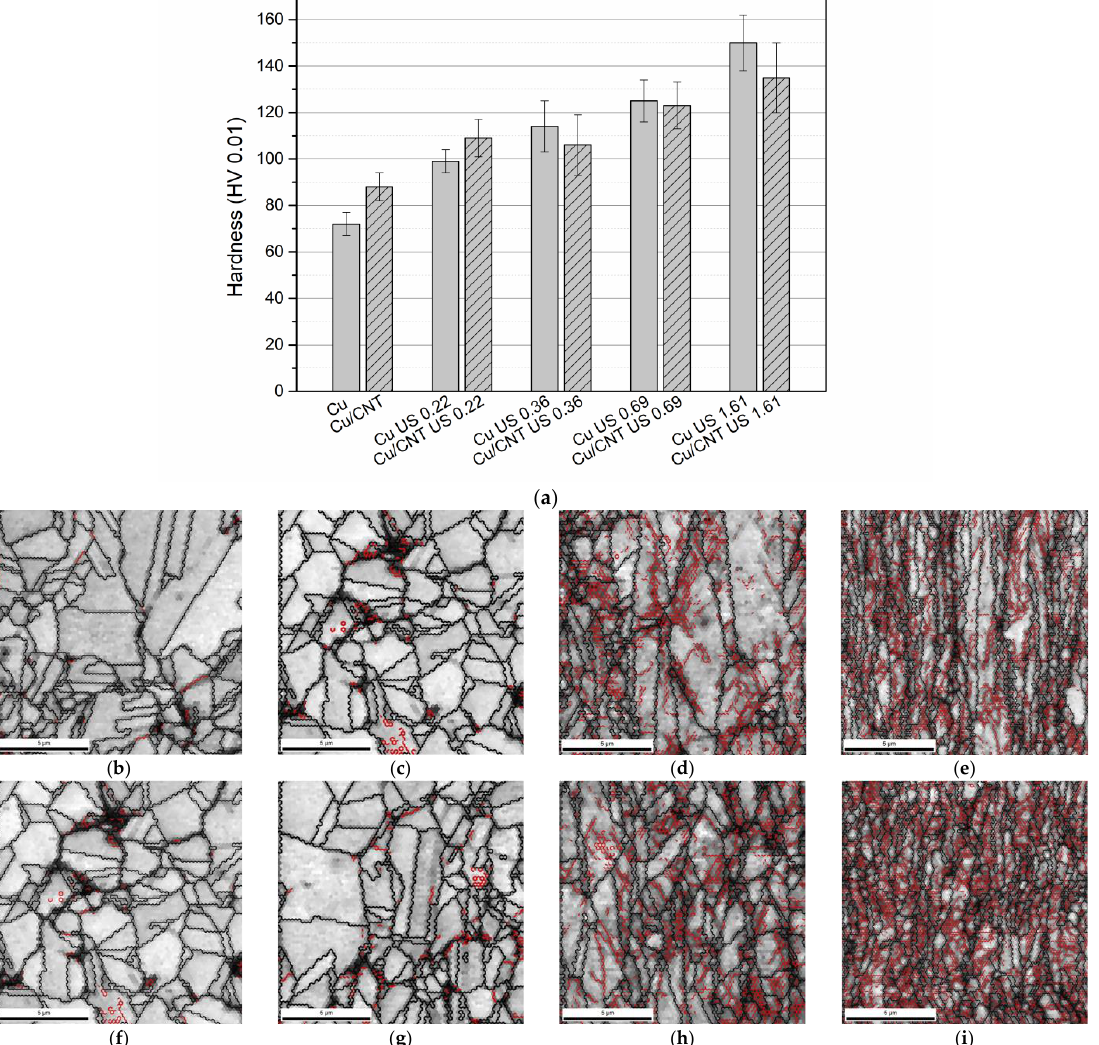
Figure 13. ( a ) Evolution of Cu and Cu/CNT microhardness with cold-rolling strain ( b – i ) and IQ maps marked with LAGBs (in red) and HAGBs (in black) for ( b – e ) Cu ( f – i ) and Cu/CNT samples, as-sintered and cold rolled to strains of 0.11, 0.69, and 1.61, respectively.